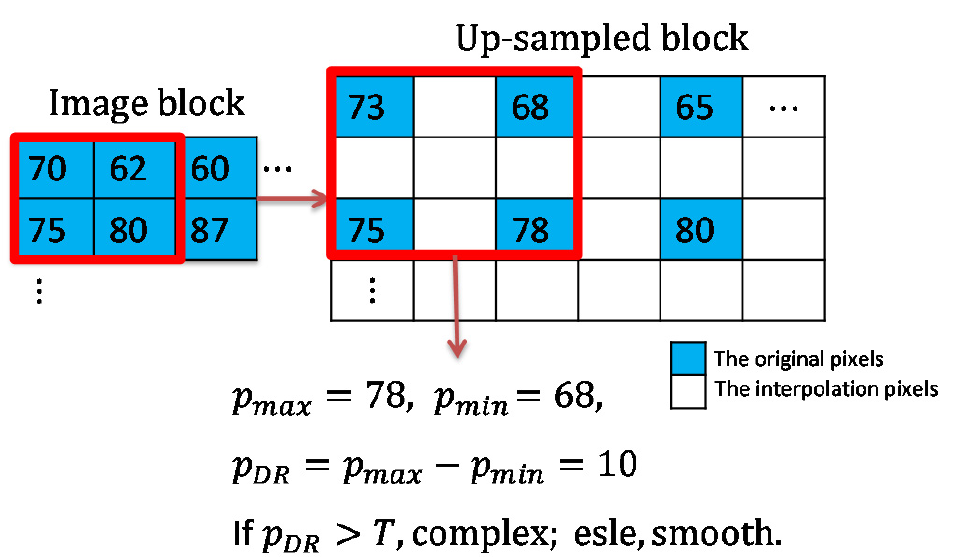
Figure 4. An example of pixel block classification.